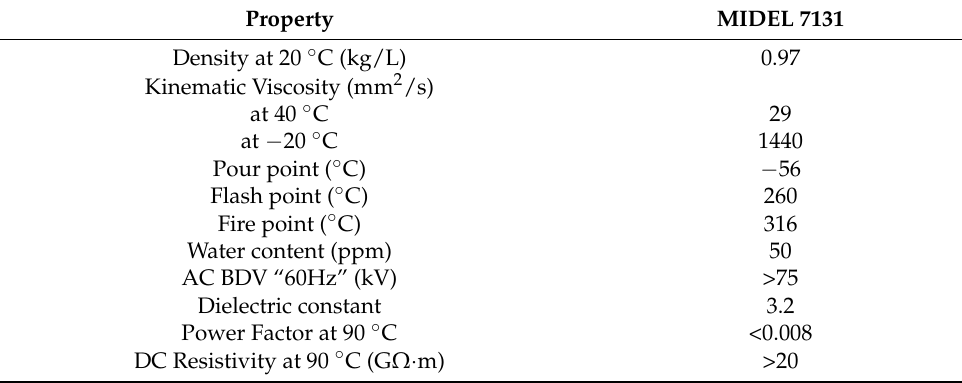
Table 1. Physicochemical Properties of Synthetic Ester, MIDEL 7131.